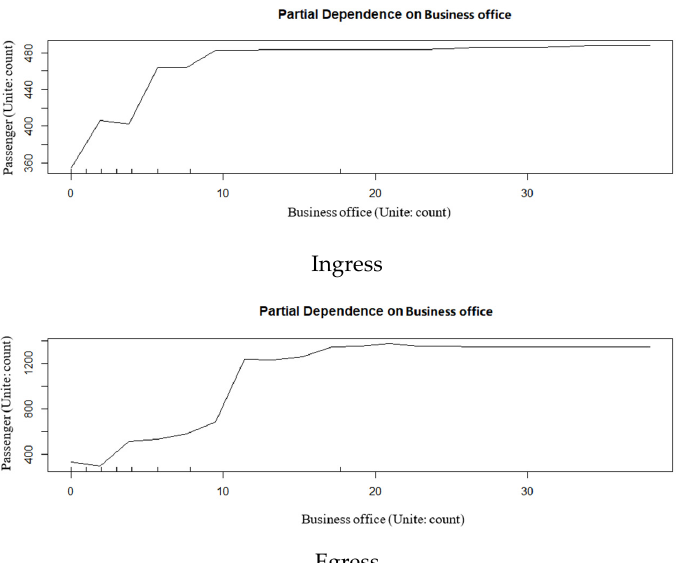
Figure 17. Partial dependence plot of business office area.